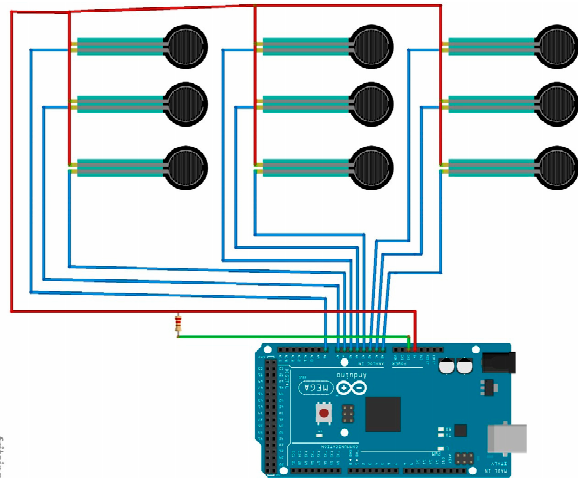
Figure 7. Circuit diagram of nine FSR sensors connected to Arduino